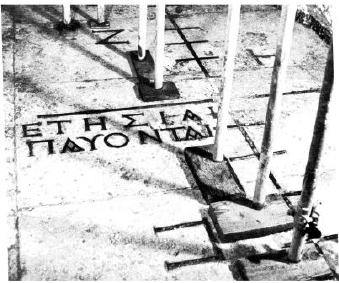
Figure 12: Scale of the meridian, discovered during the German excavation 1980/81 (Zodiac